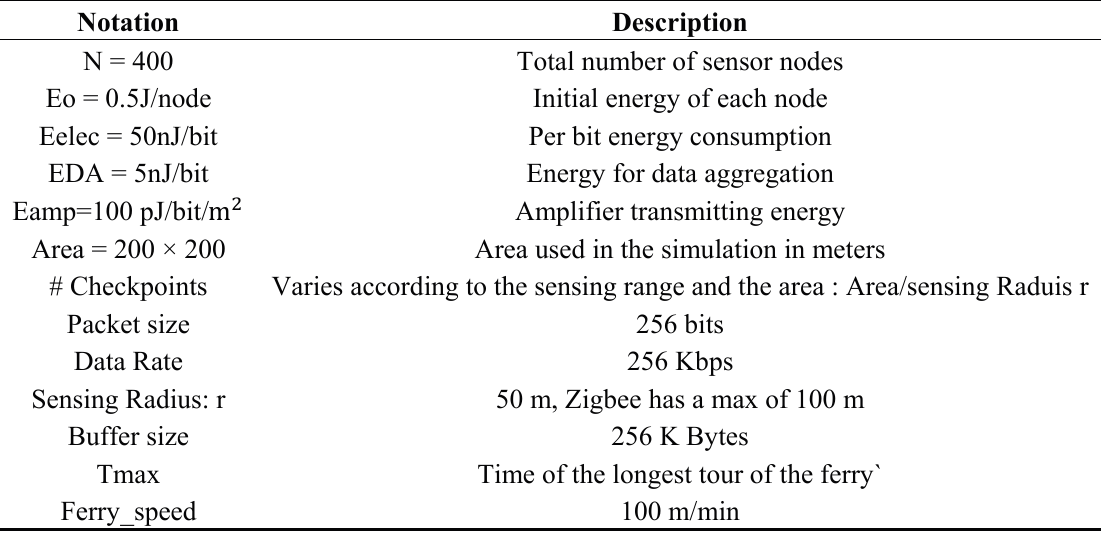
Table 1. Parameters used in the simulation, values for the various energy parameters are per the energy model used by